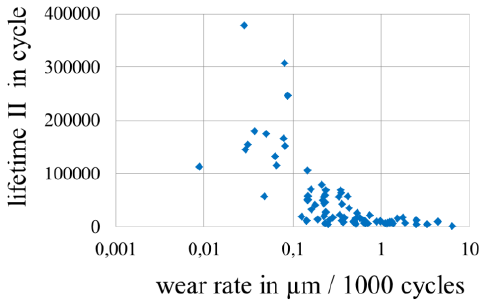
Figure 34. Correlation between rate of wear of gold platings and lifetime II of electrical